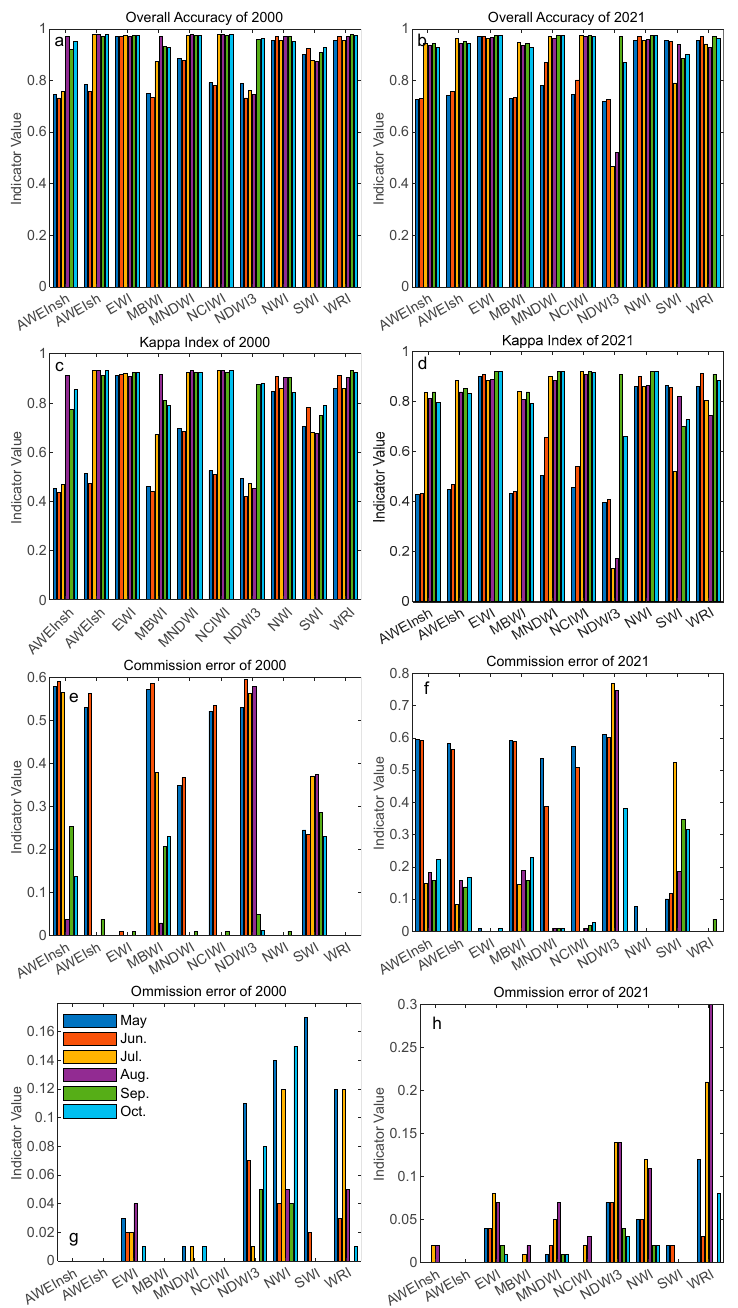
Figure 11. Evaluation plots of the OA ( a , b ), Ka ( c , d ), CE ( e , f ) and OE ( g , h ) for water extraction in the study area of Chagan Lake based on the water indices with their optimal segmentation thresholds from May to October in 2000 and 2021, respectively.